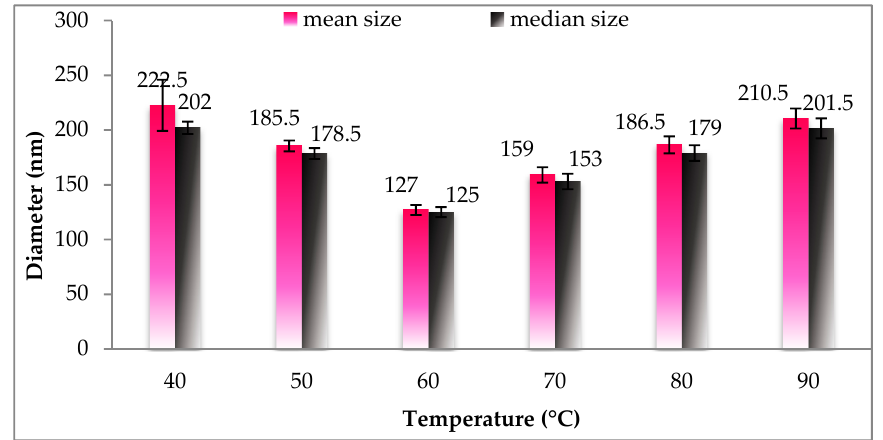
Figure 1. Size distribution of Gac oil-loaded SLNs at different temperatures of hot homogenization. SLNs: Solid lipid nanoparticles.